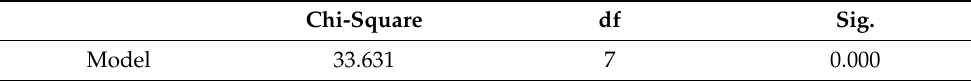
Table 5. Omnibus test.